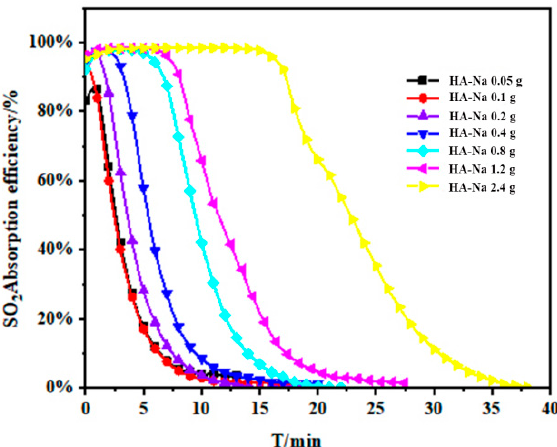
Figure 3. The effect of different quality HA–Na on desulfurization efficiency. SO 2 = 2300 ppm, gas flow = 1.68 L/min and absorption solution = 60 mL and 25 ° C.